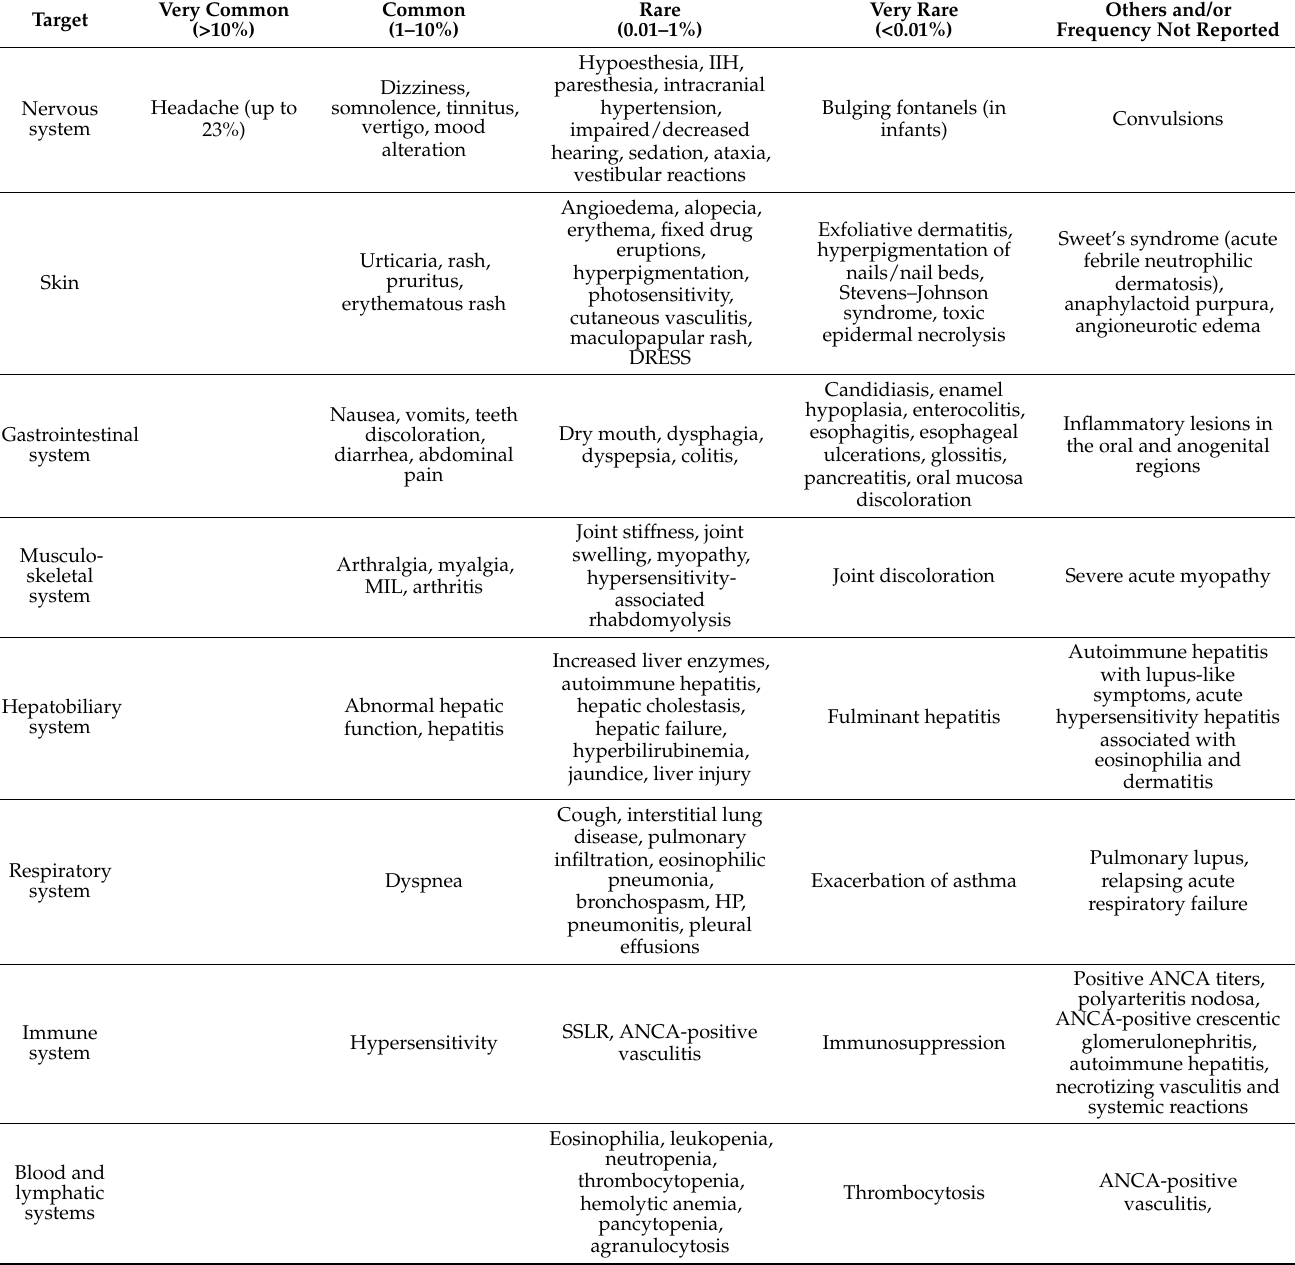
Table 2. Possible adverse effects caused by the systemic use of minocycline